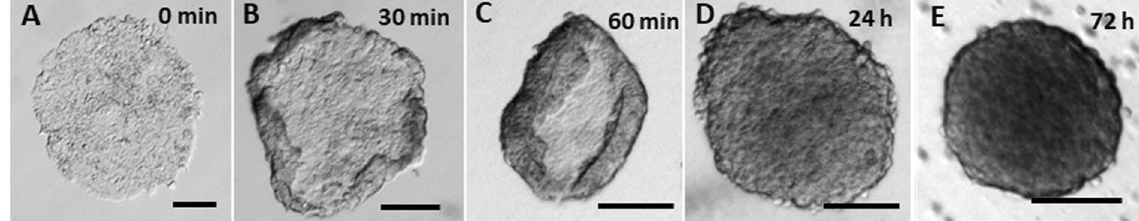
Figure 2. Contrast microscope images of HCT-116 tumor spheroids formation process. ( A ) HCT-116 cell sheet (Sheet growth = 10 days) on petri dish and ( B – E ) cell sheet was detached by dispase and kept orbital-shaking at 30 rph with dispase doped medium (1/6) for different time. All scale bars are 200 µ m.